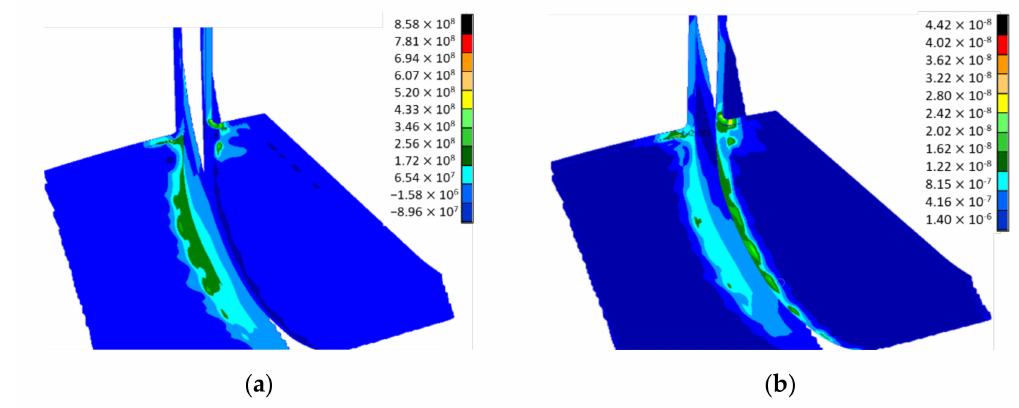
Figure 10. Maximum ( a ) principal stress and ( b ) shear stress for layer 10001.